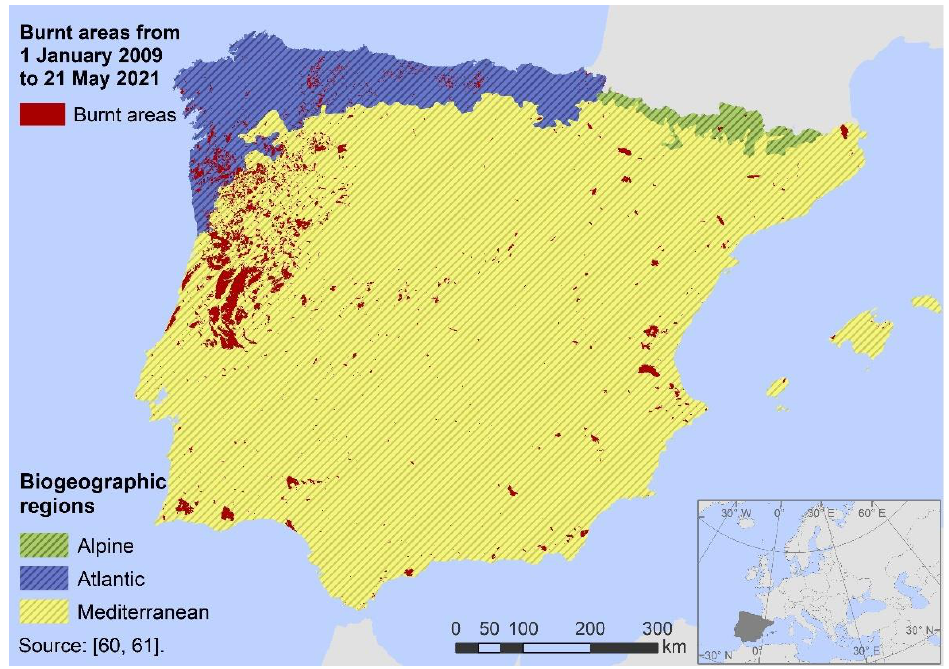
Figure 1. Study area, its biogeographic regions [60], and burnt areas from 1 January 2009 to 21 May 2021 [61].